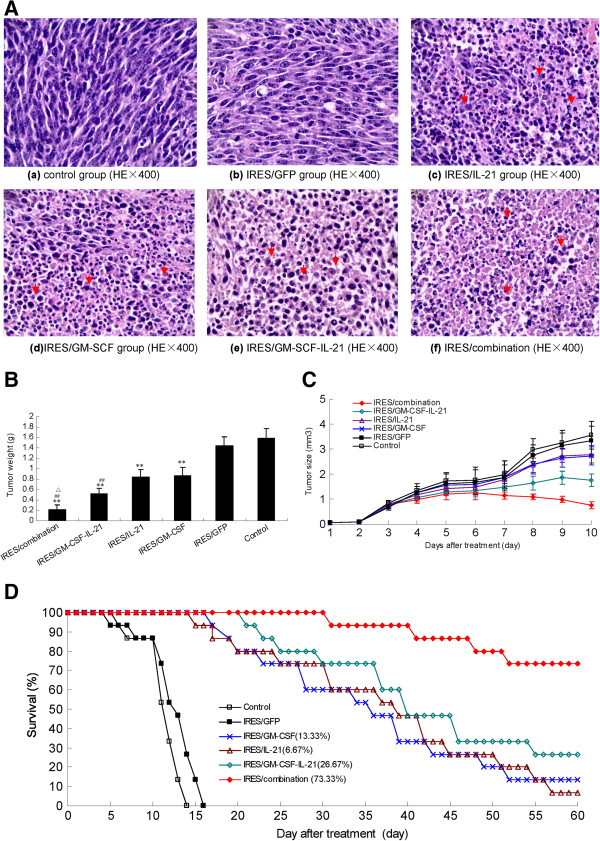
Inhibitory effects of different expression plasmids on liver cancer in a mouse model. The differential plasmid treatments were: Control, pGFP-IRES, pGM-CSF-IRES, pIL-21-IRES, pGM-CSF-IRES-IL-21, and pGM-CSF-GFP-IRES-Rae-1-IL-21. Tumor-bearing mice were sacrificed 10 d after treatment and histological sections were made from various tumor tissues. A; Histopathology of tumor tissues in mouse liver cancer (HE × 400 magnification). (a) and (b) shows histopathological tumor tissue sections in mice treated with PBS or pGFP-IRES, wherein the tumor cells grew actively. (c) and (d) shows histopathological sections from the tumor tissue of tumor-bearing mice treated with pGM-CSF-IRES or pIL-21-IRES, wherein the tumor cells grew slowly, and only few immunocytes were seen infiltrating the tumor tissue. (e) showing histopathological sections from the tumor tissues of tumor-bearing mice treated with pGM-CSF-IRES-IL-21. Infiltration of immunocytes increased appreciably and necrotic tumor cells were noticeable in the tumor tissue. (f) showing histopathological sections of the tumor tissues in tumor-bearing mice treated with pGM-CSF-GFP-IRES-Rae-1-IL-21. Here, both monocytes and neutrophils infiltrated the tumor, and there was evidence of mass necrosis seen in the tumor tissue. Note that the red arrow indicates inflammatory cells. B; showing the tumor weights (expressed as mean ± standard deviation) of mice in each group 10 d after treatment (n = 10). C; tumor volumes of mice (expressed as mean ± standard deviation) in each group 1–10 d after treatment (n = 10). D; showing the survival time of the mice in each group (n = 13) that were analyzed by the Kaplan-Meier approach. Note: **P < 0.01, as compared with the control. ##P < 0.01, as compared with the IRES/GM-SCF or IRES/IL21 expression constructs. △P < 0.05, as compared with the IRES/GM-SCF-IL-21 expression construct.